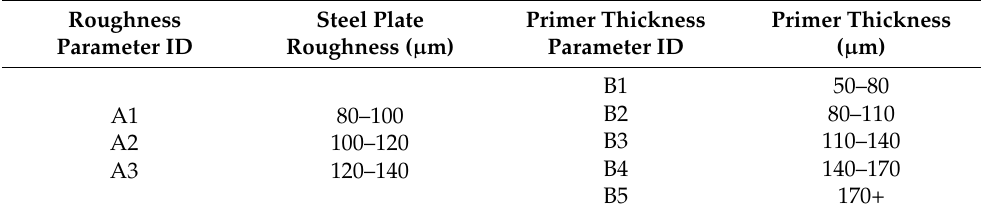
Table 9. The parameters of steel plate roughness and primer